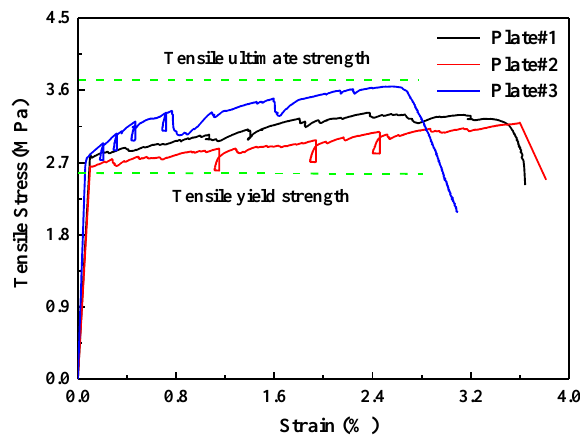
Figure 1. Uniaxial tensile stress-strain responses of polypropylene (PP)-ECC.